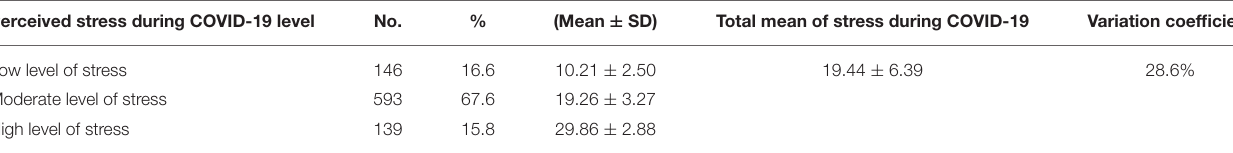
TABLE 4 | Perceived stress levels among the participants during COVID-19 lockdown ( N = 878). Perceived stress during COVID-19 level